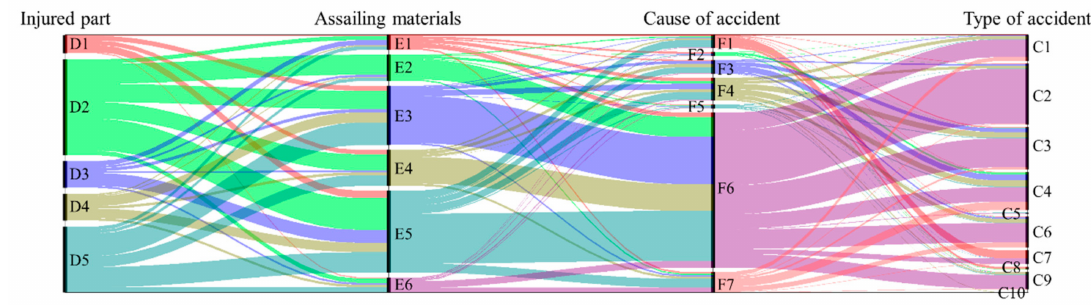
Figure 5. Alluvial flow diagram using variables with high correlation when predicting type of accident. D: Injured part (D1: Inside the upper body; D2: Outside of the upper body; D3: Face;